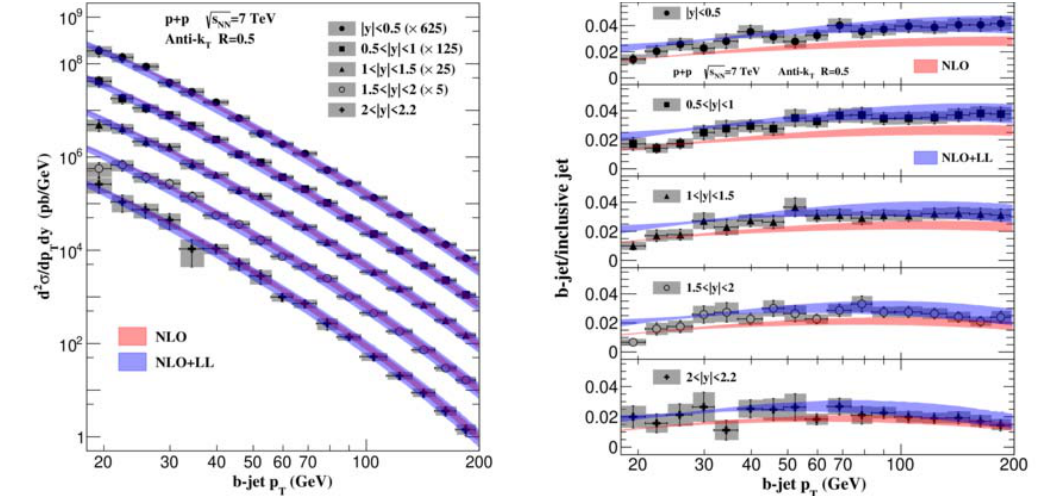
Figure 2 . Comparison of theoretical predictions and measurements for b-jets with radius R = 0 . 5 in p+p collisions at √ s = 7 TeV. The b-jet cross section (left) and the ratio of the b-jet cross NN for different rapidity section to the inclusive jet cross section (right) are shown as a function of jet p T intervals. The red and blue bands are the NLO and NLO+LL predictions, respectively, while the gray bars represent the total experimental uncertainty of the data